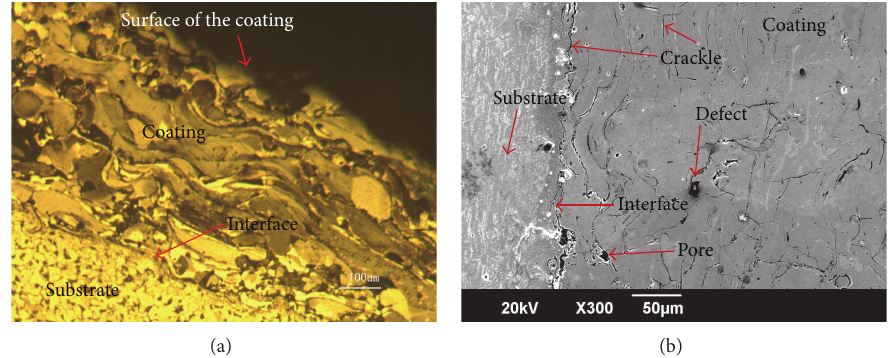
Figure 1: The optical and SEM images of the arc spraying coatings.